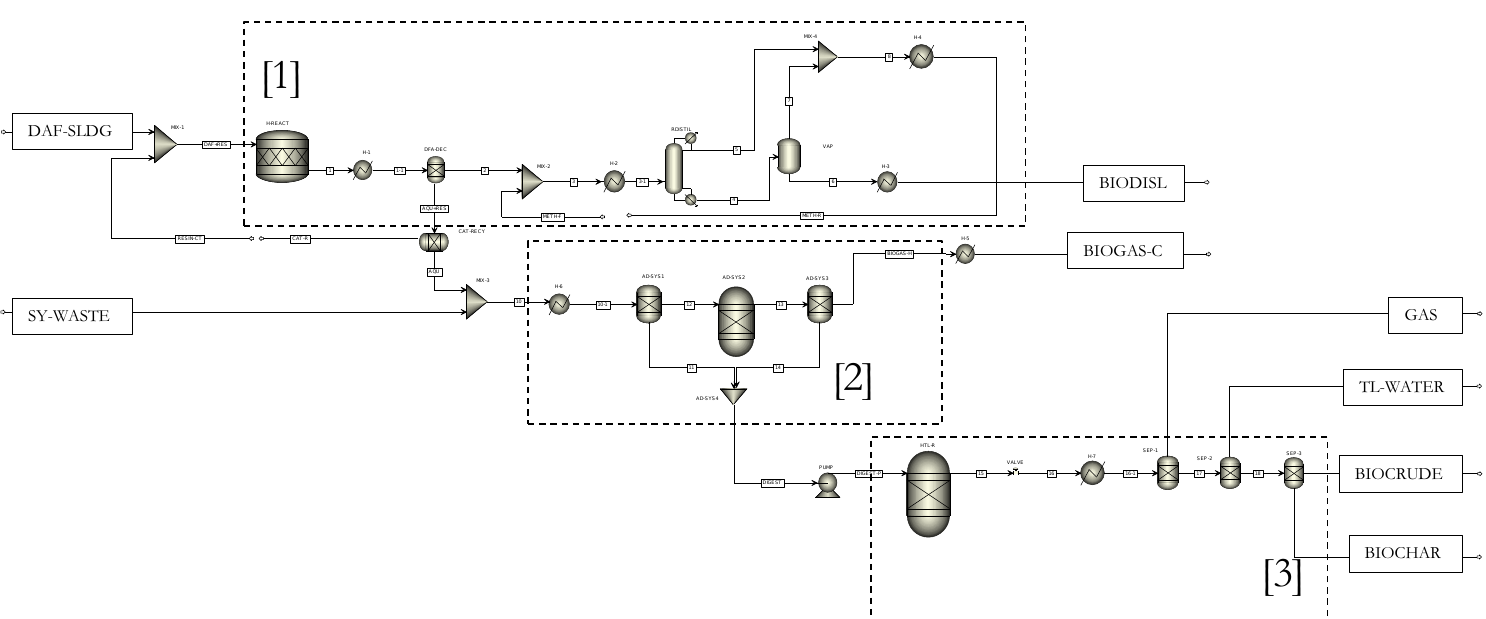
Figure 2. The simplified process flow sheet for the simulated meat processing waste biorefinery for biodiesel production process, anaerobic digestion process and hydrothermal liquefaction process. DAF-SLDG: dissolved air flotation sludge, SY-WASTE: stockyard waste, TL-WATER: hydrothermal liquefaction water, RESIN-CT: Resin catalyst, DAF+RES: Dissolved air flotation sludge plus catalyst, CAT-R: Catalyst recovered, DFA-DEC: Fatty acid separation unit, CAT-RECY: Catalyst recycle; AQU+RES; Aqueous phase products plus resin; METH-F: Methanol feed; METH-R: Methanol recovered, CAT-R: Catalyst recovered, AQU: Aqueous phase products, BIODISL: Biodiesel; RDISTIL, Reactive distillation column; VAP, Vaporiser; H-1 to H-7: Heat exchangers 1 to 7 respectively, SEP-1, SEP-2 and SEP-3: Employed in separation operations 1, 2 and 3 respectively, DIGEST: Digestate, DIGEST-P: Pressurised digestate, AD-SYS1, AD-SYS2, AD-SYS3 and AD-SYS4: Anaerobic digestion sub-systems of 1, 2, 3 and 4 respectively and BIOGAS-C (-H): Biogas at 25 °C (37 °C). Table 1. The simulation results of the major streams in the process flow sheet for the proposed biorefinery system.